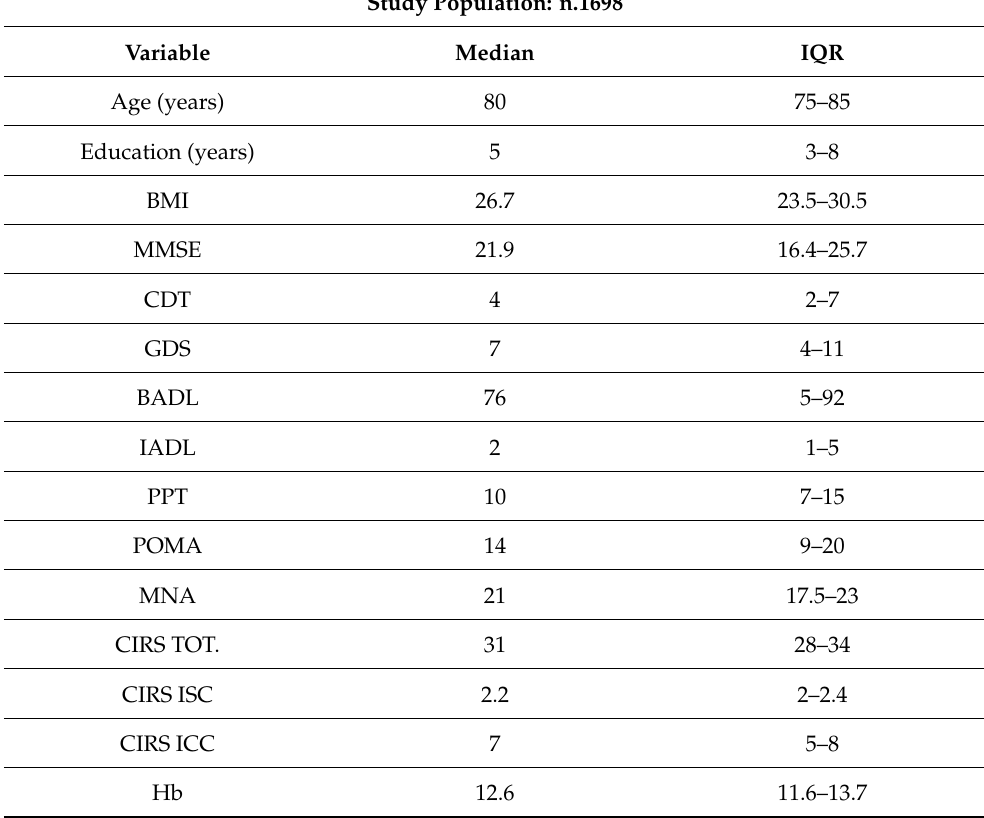
Table 1. Characteristics of the